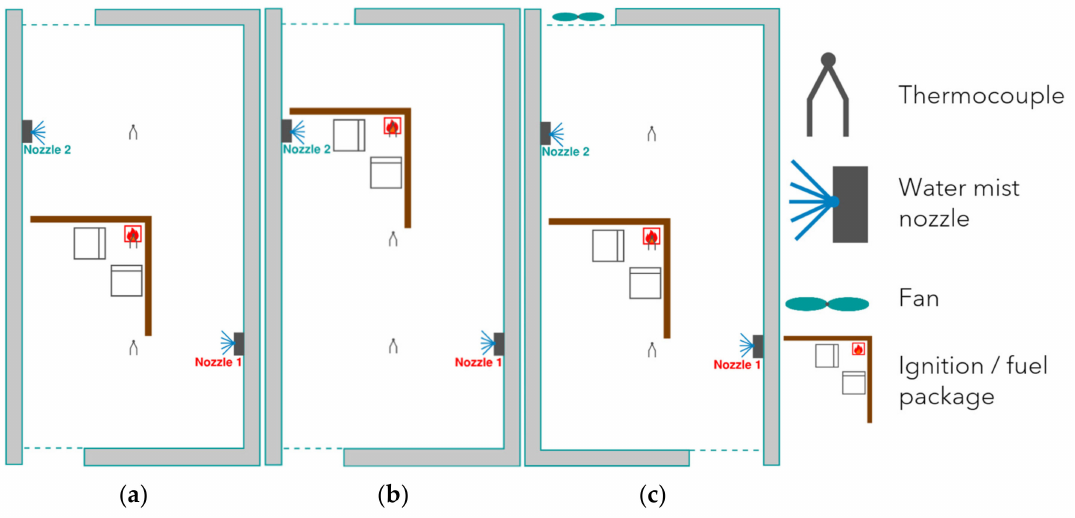
Figure 8. Indicative diagram of test arrangements: ( a ) A-02; ( b ) A-03; and ( c ) A-04. The first nozzle to activate is indicated in red